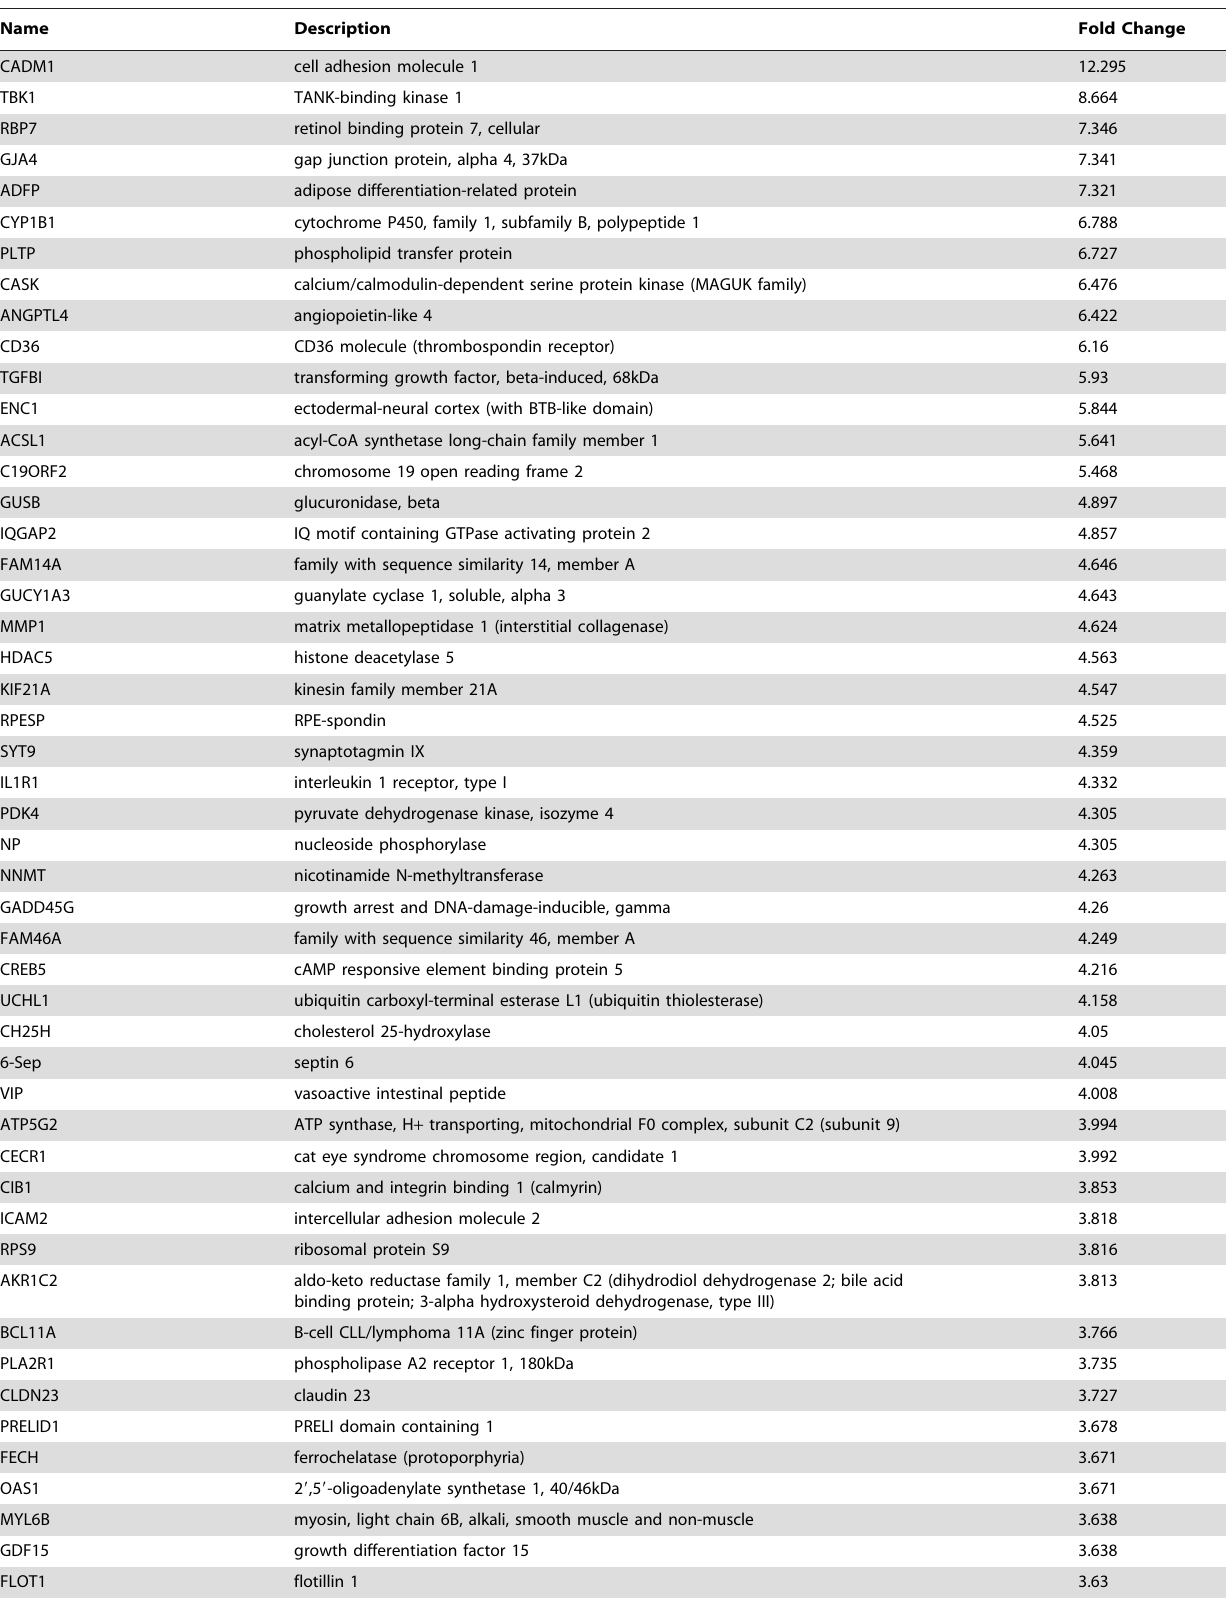
Table 1. List of MfAg induced 2-fold upregulated